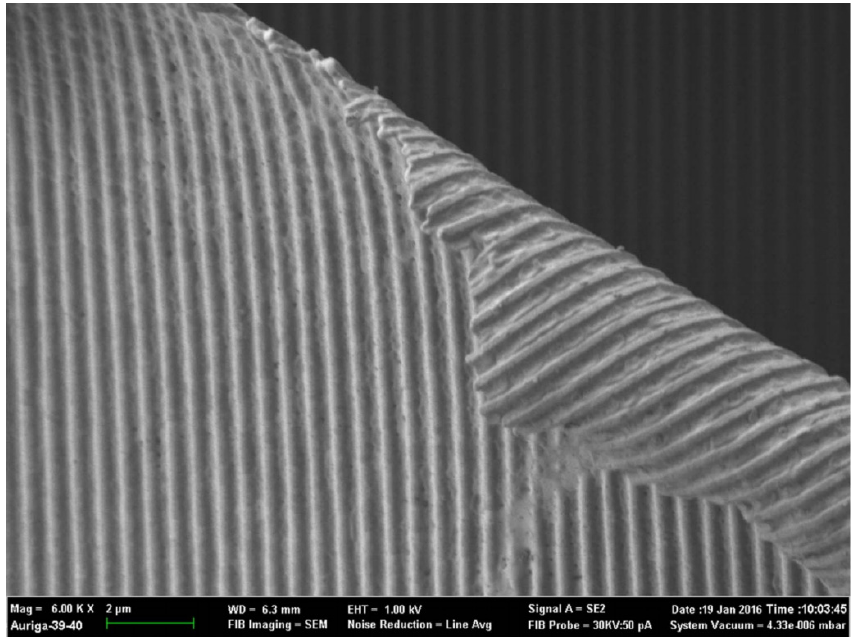
Figure 3. Laser ‐ induced damage morphology of gold ‐ coated grating. The basic grating material was photoresist, and the surface gold film was deposited by the electron ‐ beam evaporation method. The laser energy density was 0.95 J/cm 2 , the wavelength was 800 nm, and the pulse width was 60 fs. The laser was incident at the top ‐ left side. A one ‐ on ‐ one test mode was used in the experiment. Z. Xia, Y. Wu, et al. [21] designed a gold ‐ coated grating in 2018. The period of the grating was 574.7 nm, the groove depth was 232 nm, the duty cycle was 0.82, and the − 1 order of the grating was constructed in the 700–1000 nm band. The diffraction efficiency implemented, and the laser-damage threshold of the manufactured grating was 0.62 J/cm 2 . As shown in Figure 4.